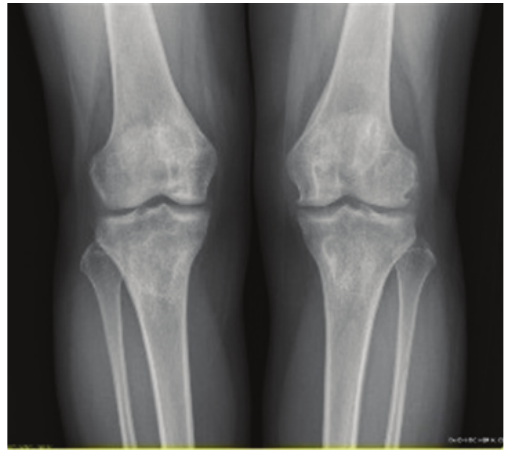
Figure 1: Density changes, sclerosis with cyst like formations in bony trabecula at distal femur and proximal tibia in AP radiogram.